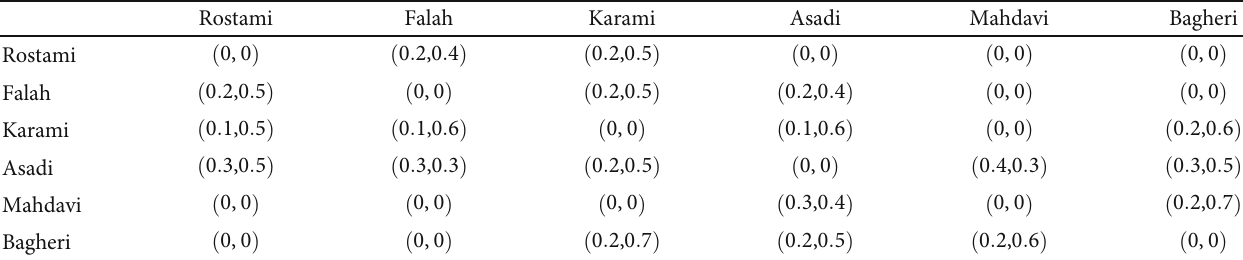
Table 4: Adjacency matrix corresponding to Figure